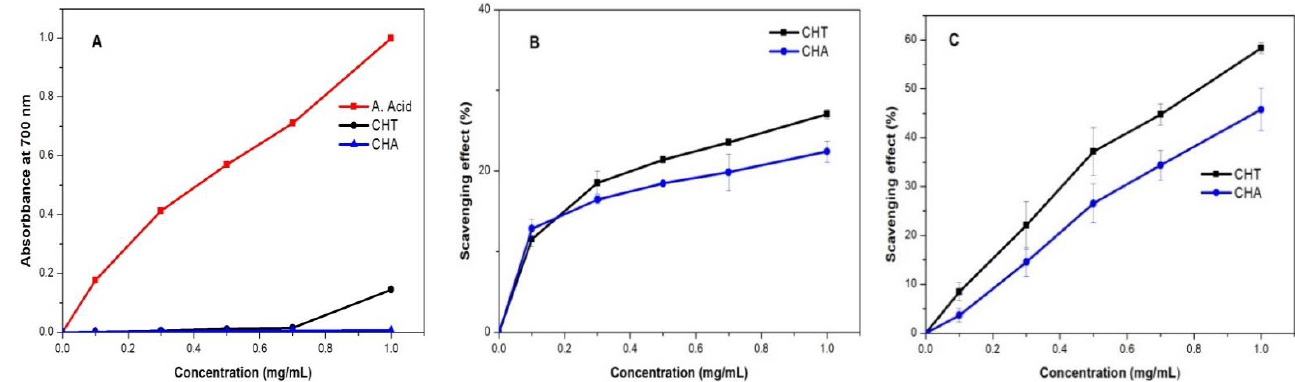
Figure 9. Antioxidant Activity of CHT and CHA: ( A ) reducing power; ( B ) scavenging of hydroxyl radical; ( C ) scavenging of DPPH radical.